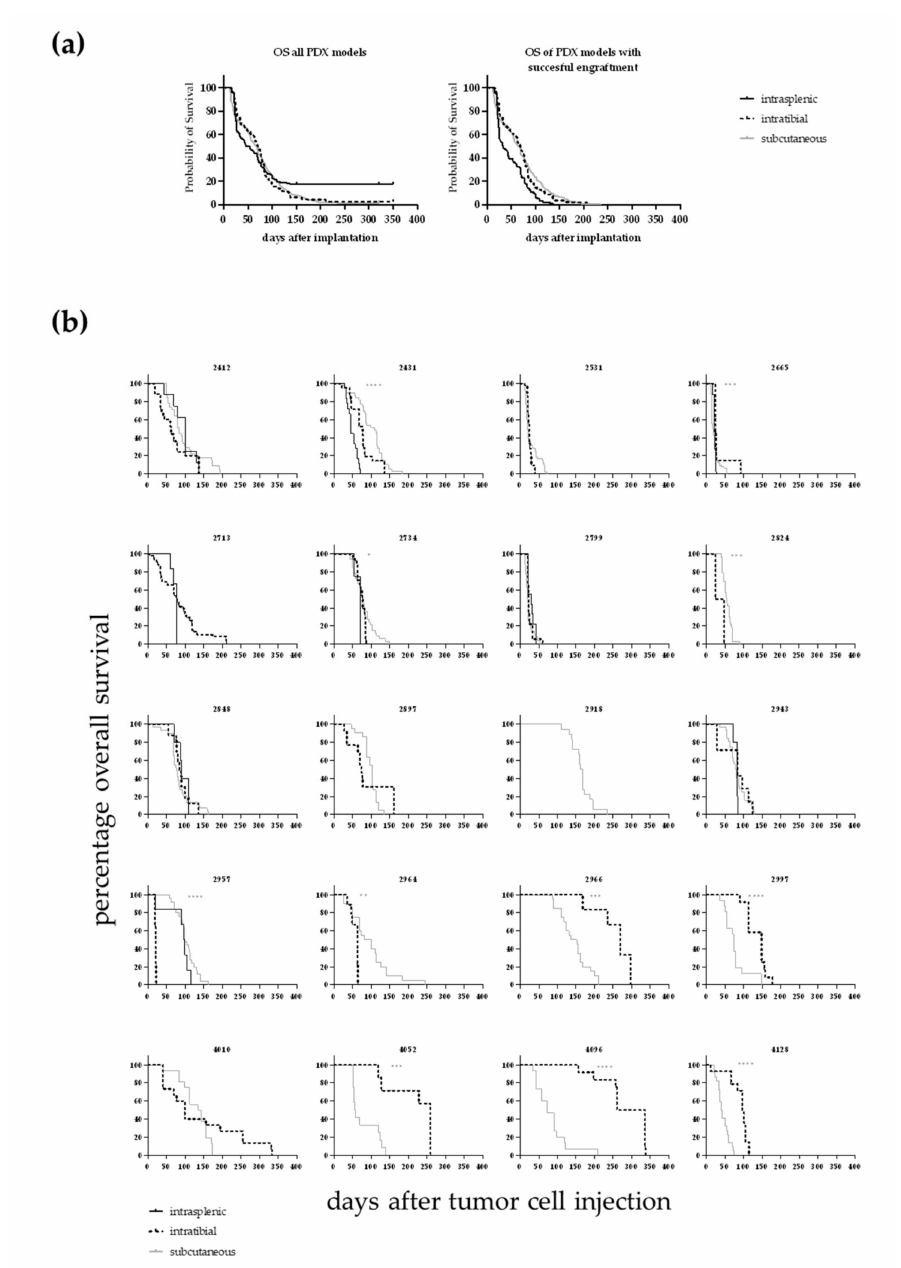
Figure 3. ( a ) Overall survival of 12 di ff erent leukaemia PDX dependent on the implantation route. In the case of the intrasplenic injection the outcome was influenced by the fact that three out of twelve tested models did not show any tumour growth during the observation period. In the left panel the OS is plotted for all models. The di ff erences were statistically significant for i.s. vs. s.c.. In case only the models were taken into account which did show successful engraftment of leukaemic cells the i.s. implanted cells grew significantly faster than the s.c growing cells (right panel, all Log-rank (Mantel–Cox) test). ( b ) Overall survival determined in 20 leukaemia PDX models for up to three di ff erent injection sites. For 20 PDX models the overall survival rate was determined over time depending on the application route of the cancer cells. For 14 out of the 20 models a statistically significant di ff erence between the implantation techniques was determined (Log-rank (Mantel–Cox)